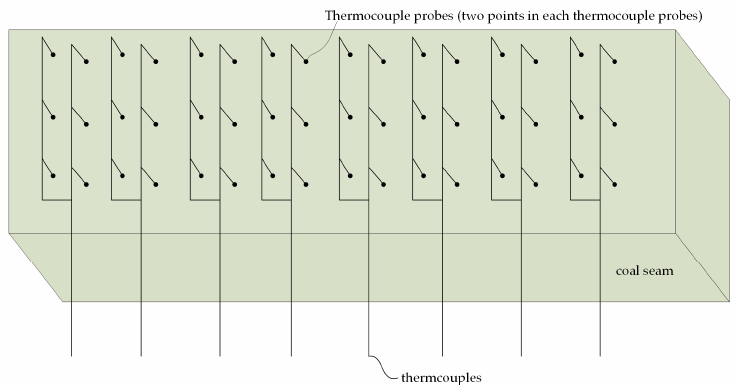
Figure 4. Physical layout of thermocouples in the coal seam.